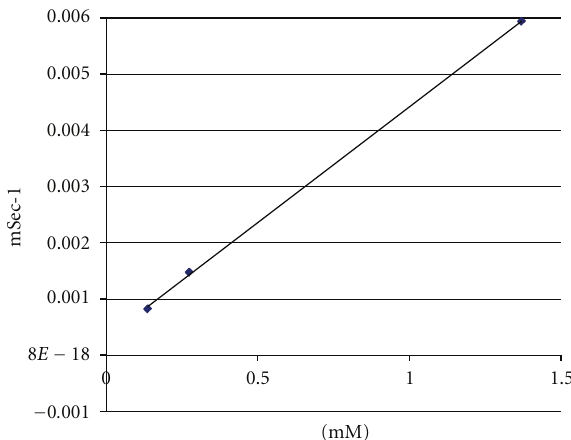
Figure 4: One of several experimental trials for determining the relaxometry properties of HA-DTPA-Gd complexes. The Relaxivity was calculated by estimating the slope of the relaxation rates (R) as a function of concentration